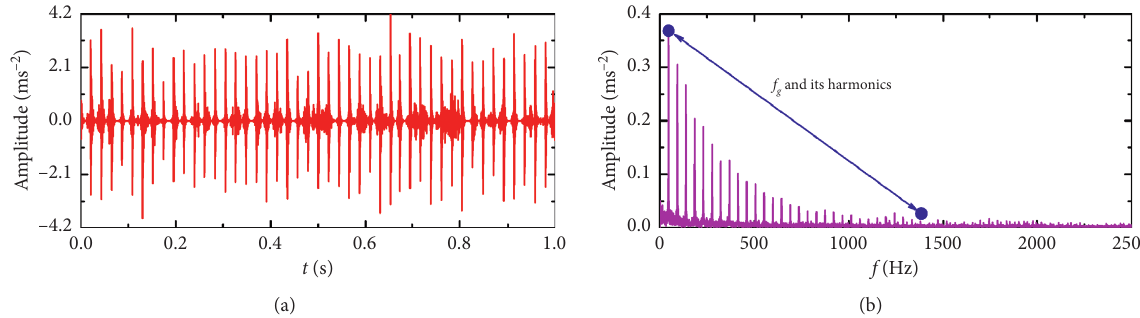
Figure 10: The simulated results using ALIF-OMPK with error goal: (a) extracted signal and (b) Hilbert envelope spectrum of signal in